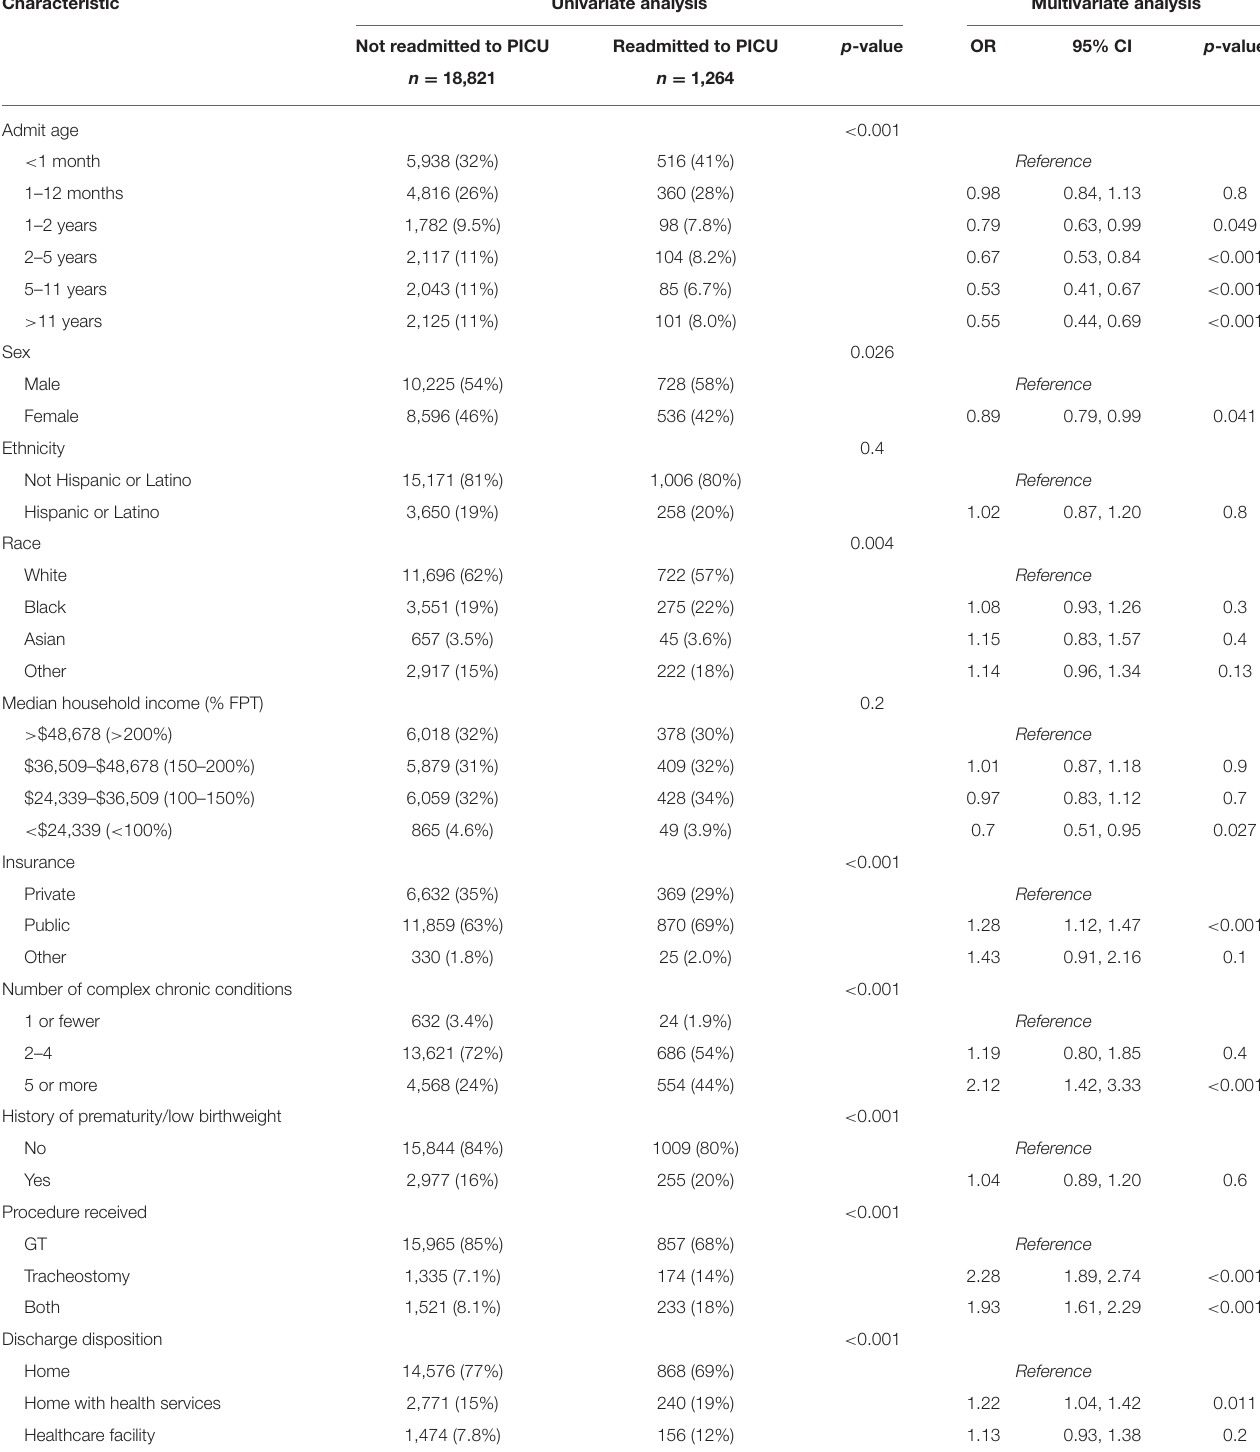
TABLE 2 | Univariate and multivariate analysis of characteristics associated with a 30-day PICU readmission in a cohort of technology-dependent children. Characteristic Univariate analysis Multivariate